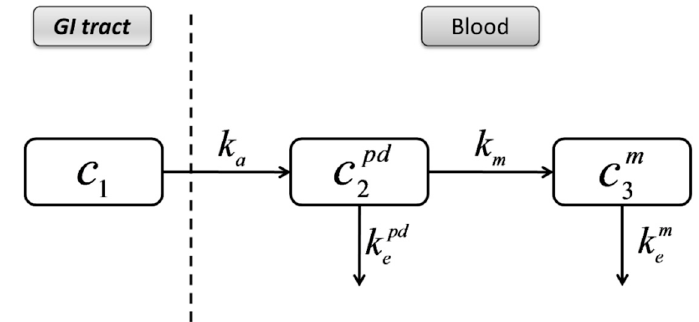
Figure 9. Schematic of processes involved in the pharmacokinetics of drugs that undergo substantial metabolism.